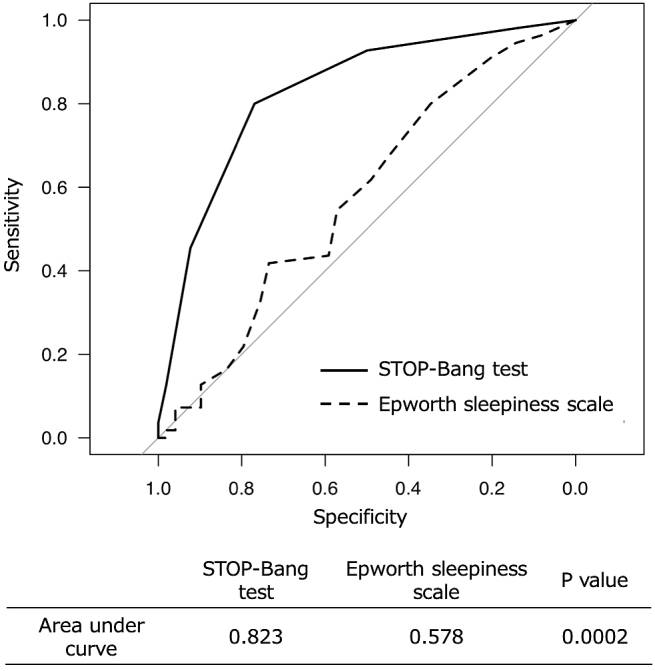
The receiver operating characteristic curve analysis of the STOP-Bang test and Epworth sleepiness scale for detecting severe OSA.